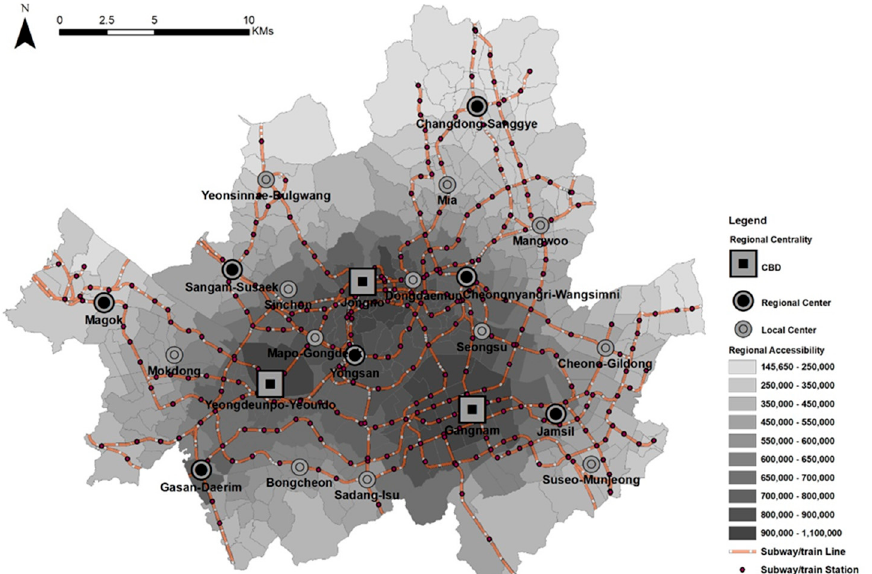
Figure 2. Map of Seoul: Location of central places suggested in the 2030 Seoul Master Plan [54], regional job accessibility of 424 Dong (literally means a neighborhood in Korean, and it is the smallest administrative unit in Seoul. This spatial unit, Dong , is used as the TAZ in Korea) in 2015, and location of subway lines and stations in 2015.